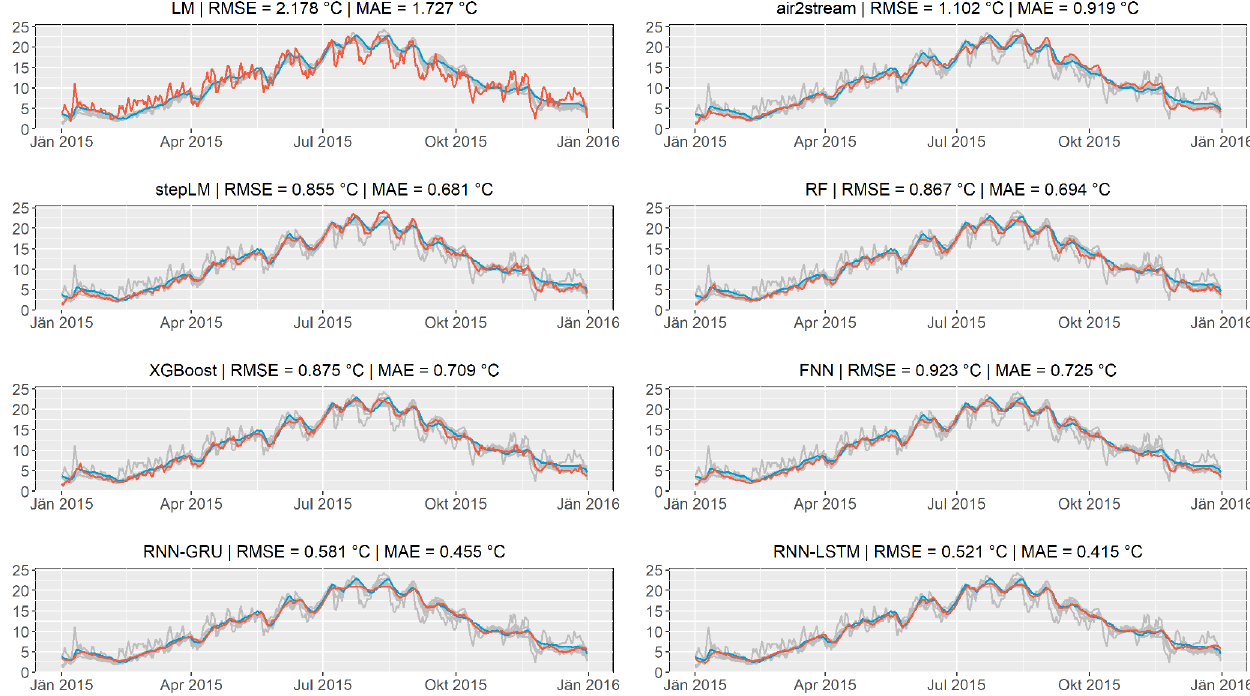
Figure A2. Comparison of the prediction of all tested model types for the Danube catchment for the year 2015. Prediction results for each model are shown with red lines, while the observations are shown with blue lines. The predictions of all other models are shown with grey